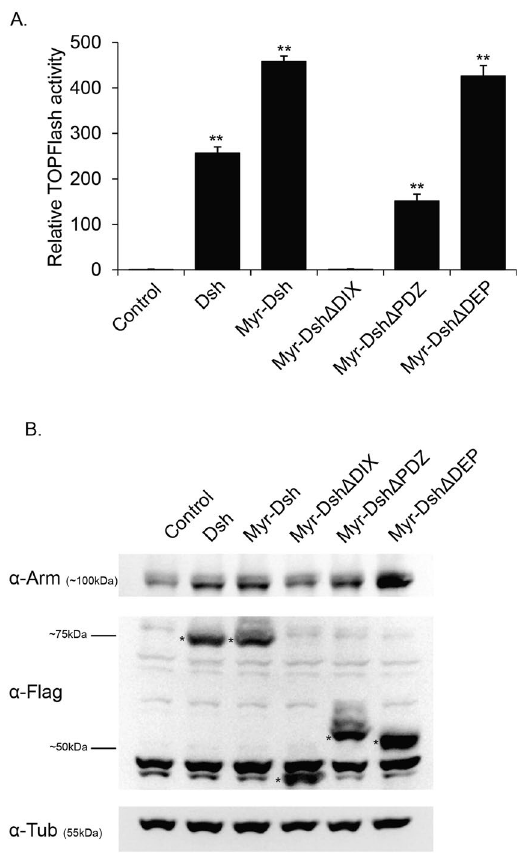
Figure 6. ( A ) Effects of Dsh deletion constructs on TOPflash reporter activity. S2R + cells were co-transfected with TOPflash reporter plasmid, Renilla luciferase-Pol III Vector and the indicated Dsh constructs. Mock transfected S2R + cells were treated as the baseline (control) for Wnt signaling activation. Results are representative of three independent experiments and the average of three replicates (mean ± SD). Statistical significance was tested using the Student’s t-test. ** p < 0.01 relative to control. ( B ) Western blot comparing total Arm protein levels in cells transfected with the Flag tagged Dsh constructs indicated with * . α -tubulin was used as a loading